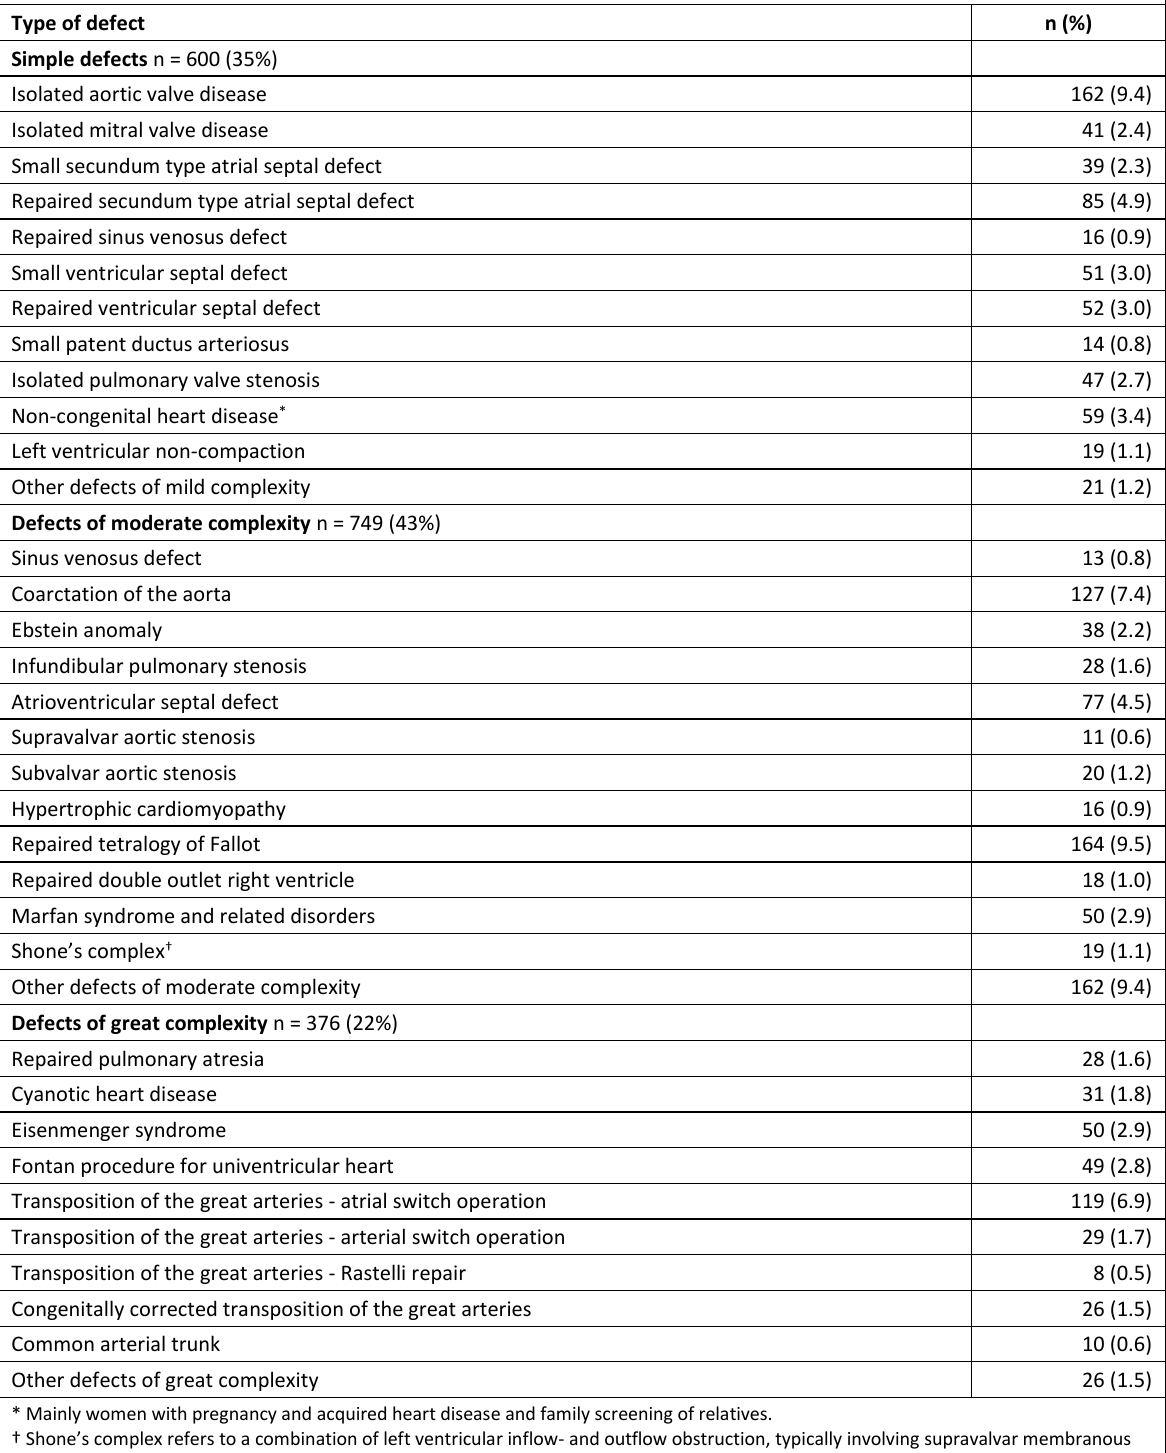
Table 1: Type and frequency of congenital heart defects within the study cohort. Type of defect n (%) Simple defects n = 600 (35%) Isolated aortic valve disease 162 (9.4) Isolated mitral valve